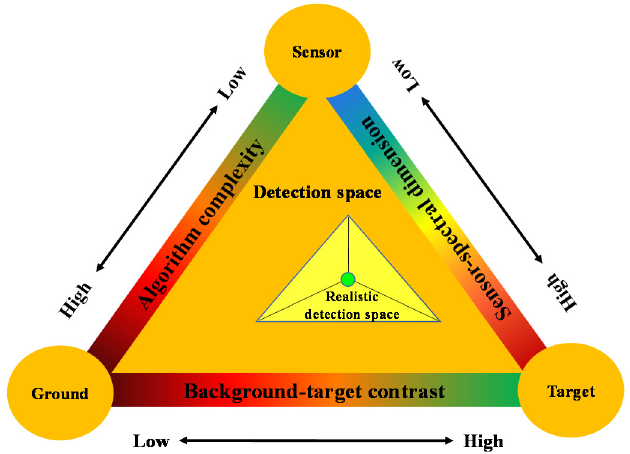
Figure 22. Various elements of a target detection system and their mutual correlation in the detection space.